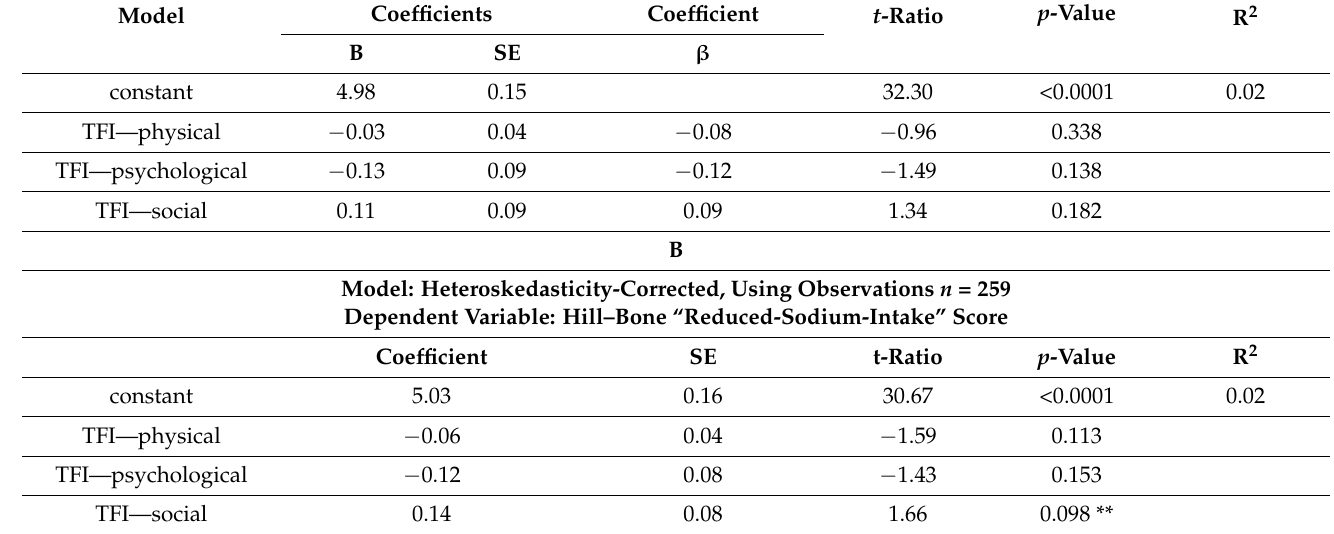
Medication-taking